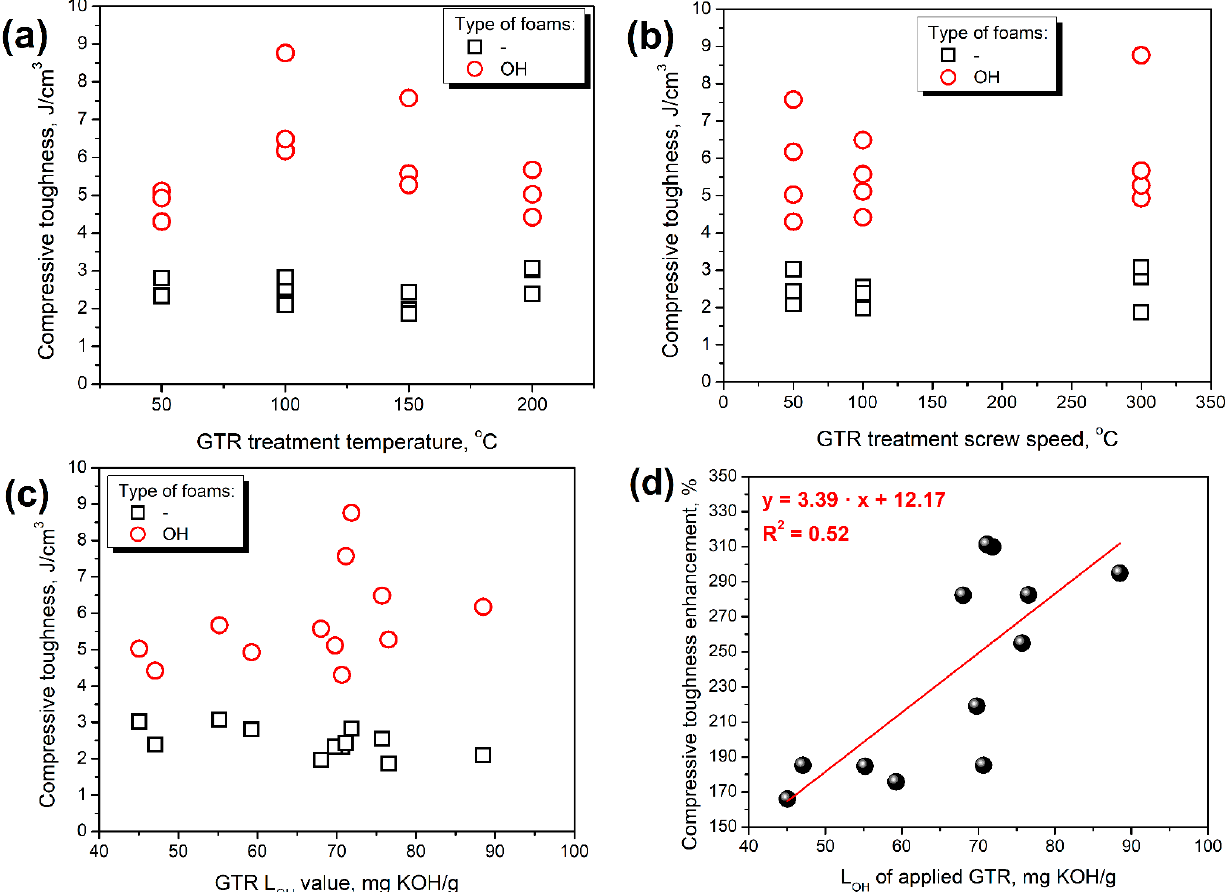
Figure 6. The impact of ( a ) GTR treatment temperature, ( b ) GTR treatment screw speed, and ( c ) GTR L OH value on the compressive toughness of prepared PU/GTR composite foams, and ( d ) the relationship between L OH of applied GTR and compressive toughness enhancement of PU/GTR composite foams after formulation adjustments.